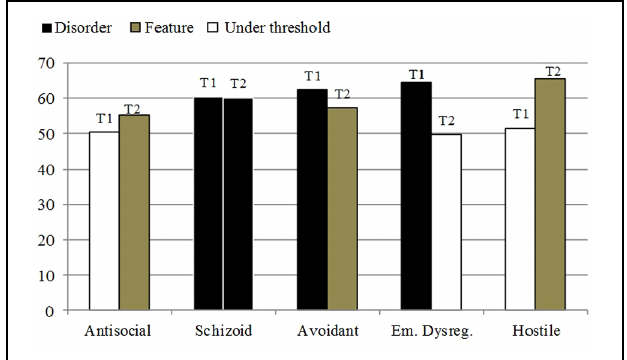
FIGURE 4 | SWAP-200 Q-Factor T -Scores at the beginning of the psychotherapy and after 1